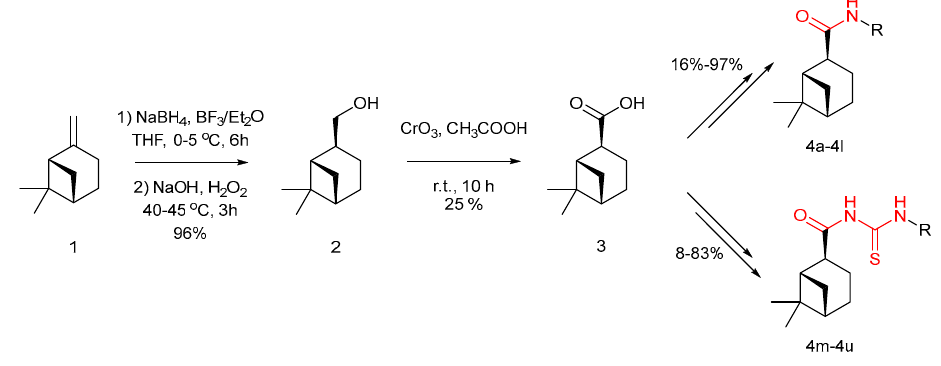
Figure 1. Synthesis route of the β -pinene-based derivatives.